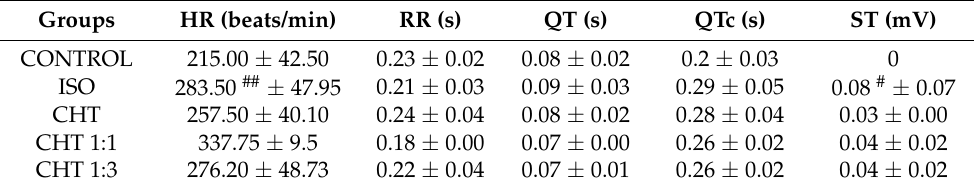
Table 4. ECG parameters (RR, QT, QT corrected, ST intervals and heart rate) in rat isoprenaline- induced myocardial ischemia.